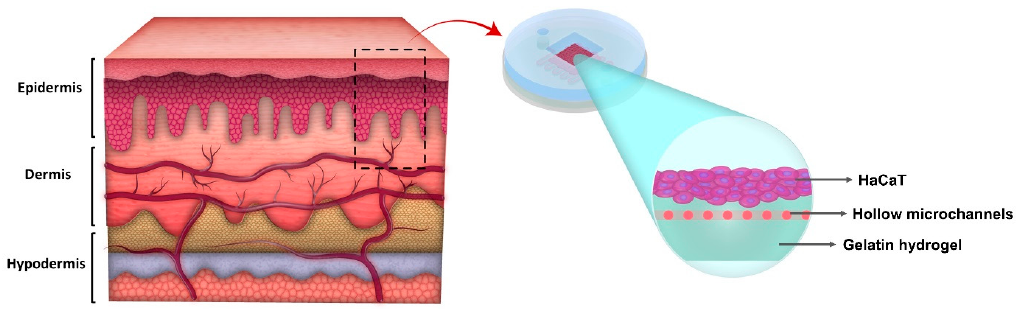
Figure 1. Simplified skin model including the epidermal layer as the first and main barrier of skin.